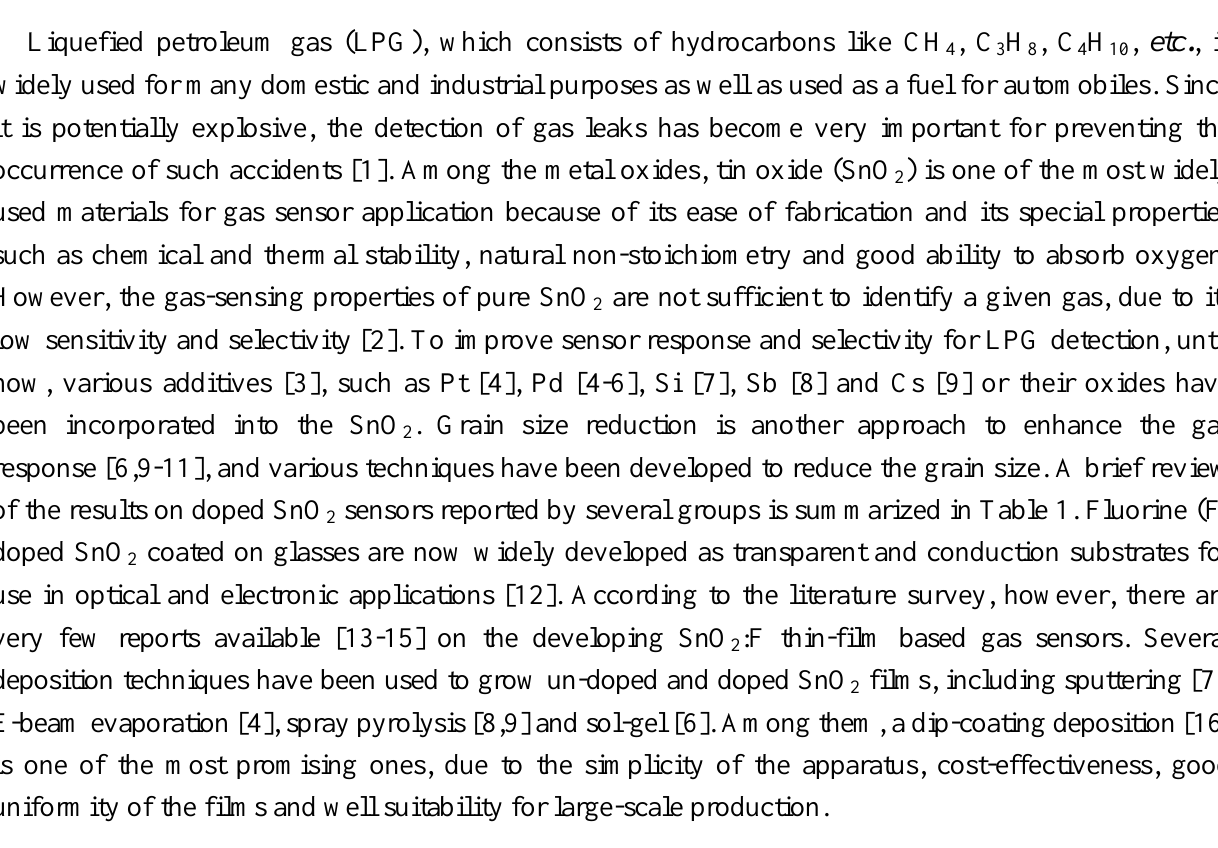
Table 1. Brief review of the results on doped SnO